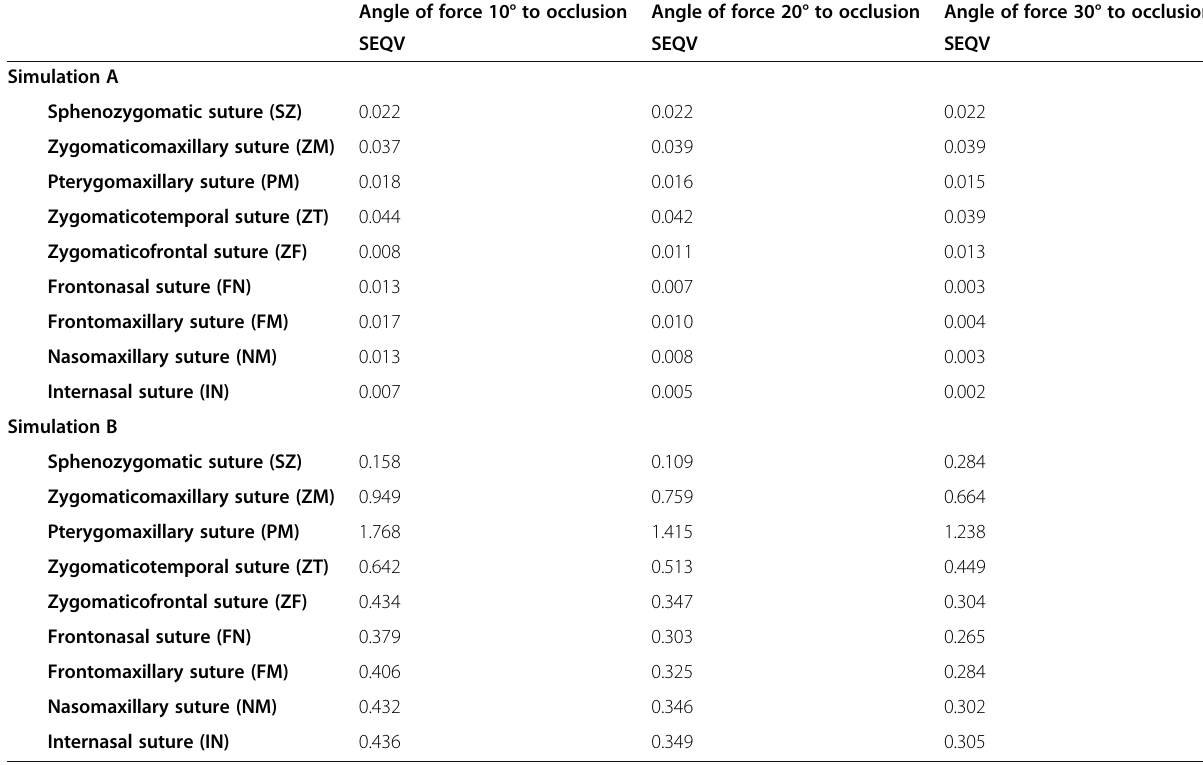
Table 2 Stress pattern along the craniofacial sutures in maxillary protraction without maxillary expansion (Simulation A) and with expansion (Simulation B) when 250-g force was applied